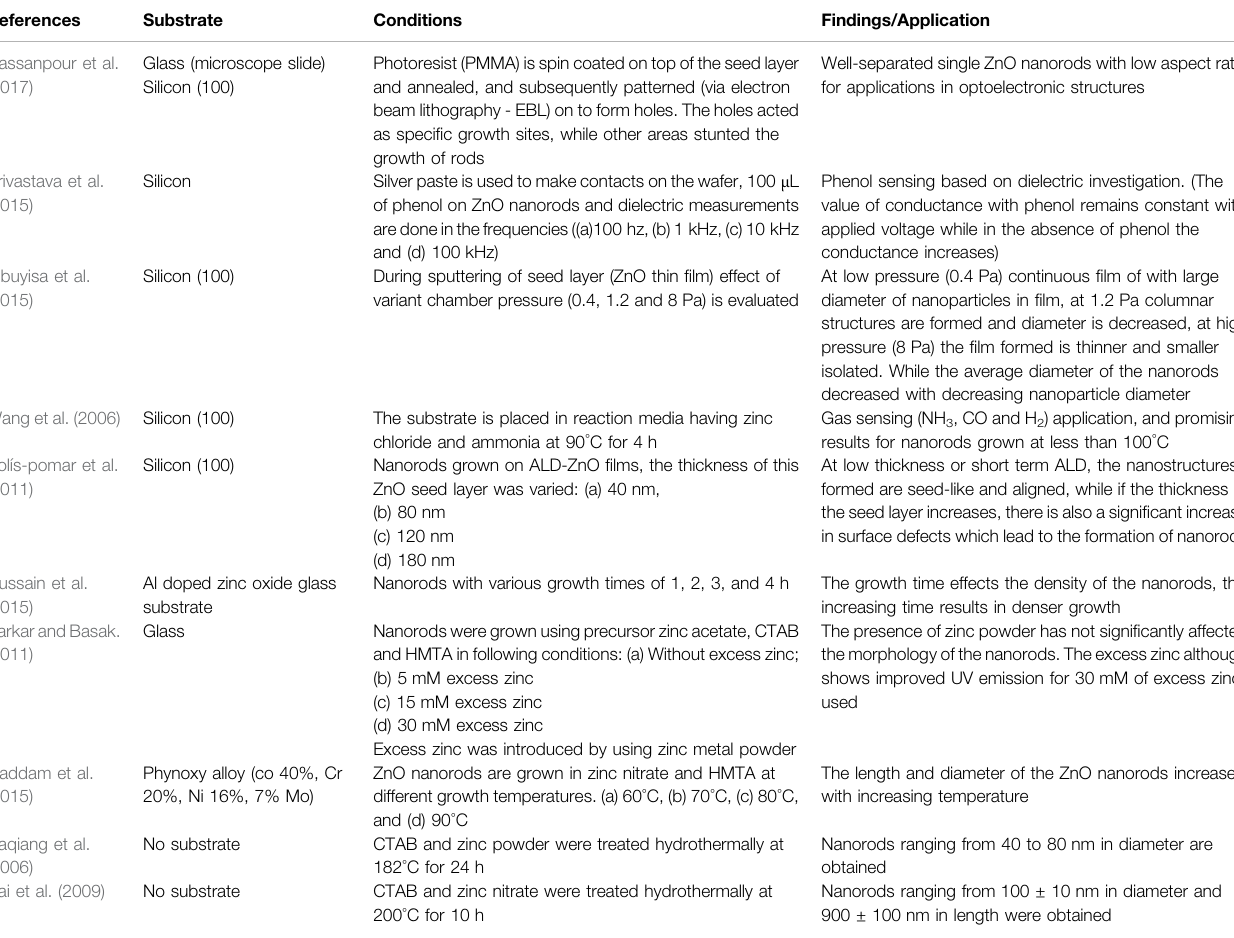
TABLE 1 | Summary of the reported work for ZnO nanorods synthesis by hydrothermal